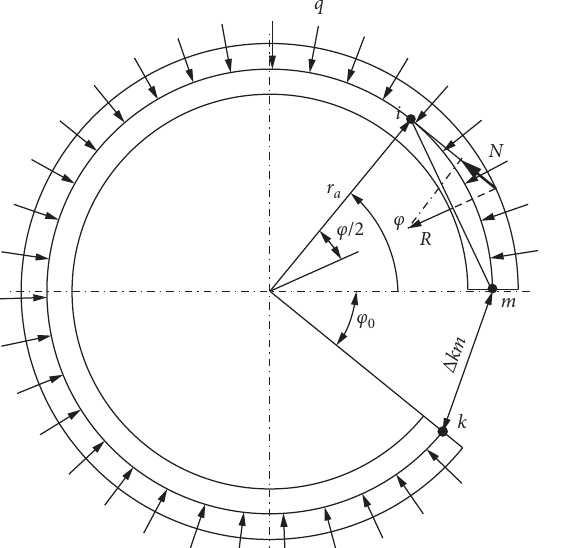
Figure 3: Diagram of the loaded state of the